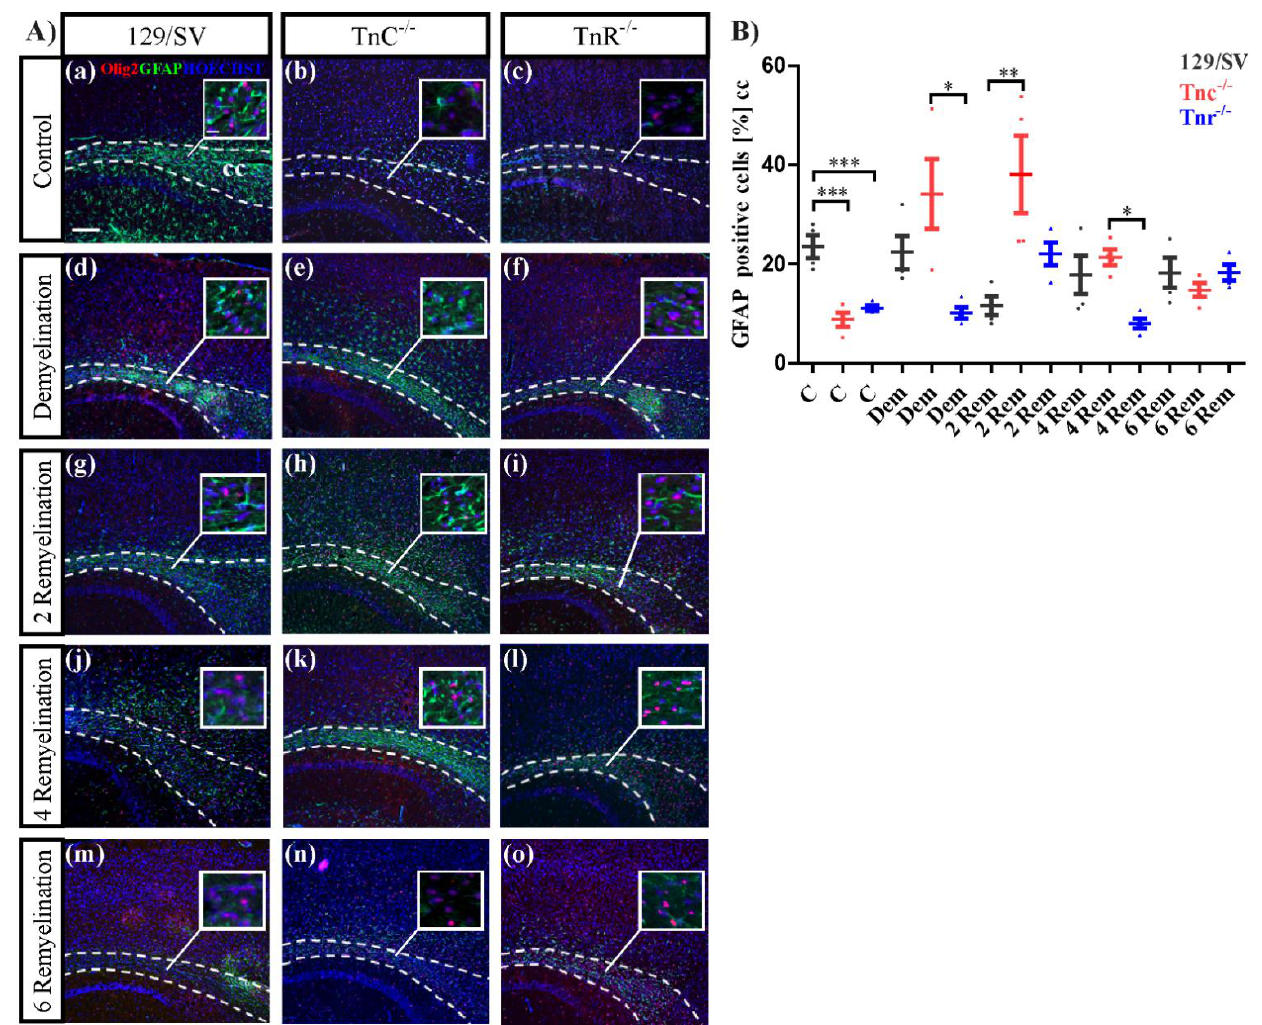
Figure 7. Reactivity of astrocytes in the lesion territory. ( A ( a – o )) Sagittal sections of the three different genotypes 129/SV, Tnc −/− , and Tnr −/− mice in the cuprizone model were immunocytochemically stained with antibodies against GFAP (green) as a marker for astrocytes and Olig2 (red) as a marker for oligodendrocytes. Hoechst dye served as a marker for cell nuclei (blue). Five different conditions were analyzed: control (C), demyelination (DM), 2-, 4- and 6 weeks of remyelination (RM2, RM4 and RM6). Images show the caudal part of the corpus callosum (CC) above the hippocampus (HC), circle triangle squares show a better visualization of the cells. In untreated control conditions, the number of astrocytes was significantly decreased in both knockout ( Tnc −/− and Tnr −/− ) mice ( A ( a – c ), B ). During demyelination and the early stage of recovery, after 2 weeks of withdrawal of cuprizone treatment, in Tnc −/− significantly more astrocytes were detectable in comparison to the wildtype mice and untreated control condition ( A ( a – i ), B ). Otherwise, no significant differences between the three genotypes were visible ( A ( j – o ), B ). Data are presented as mean ± SEM and statistical significance ( p ≤ 0.05 *, p ≤ 0.01 **, p ≤ 0.001 ***) was assessed using the ANOVA and Tukey’s multiple comparison test (control, demyelinated, remyelinated). Four independent experiments were performed (N = 4).